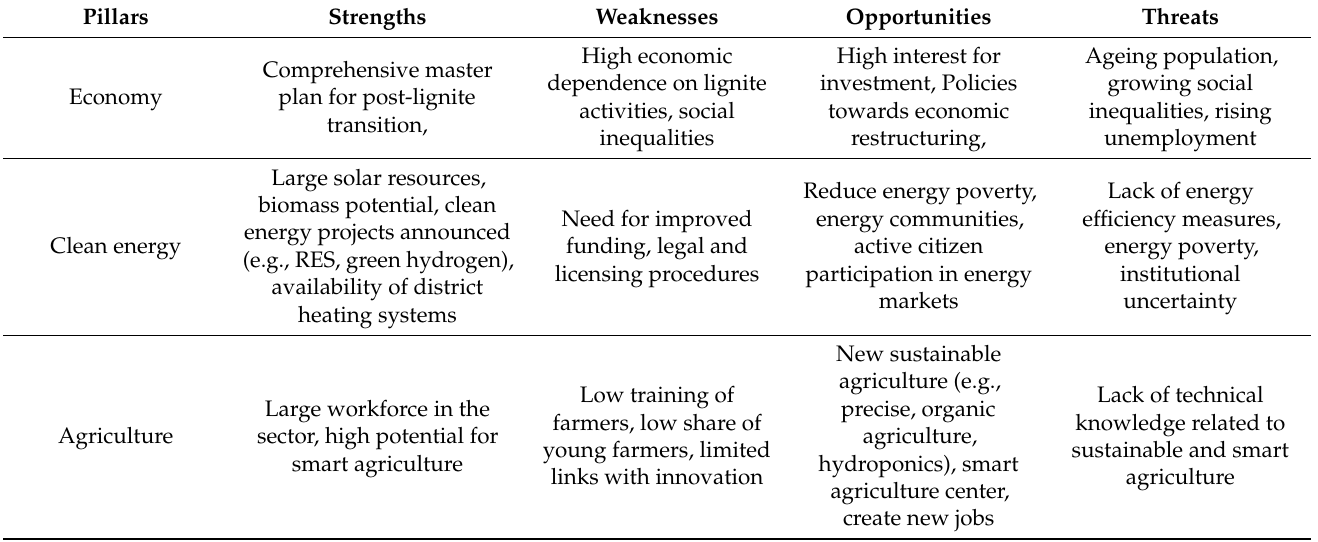
Table 2. SWOT analysis of Western